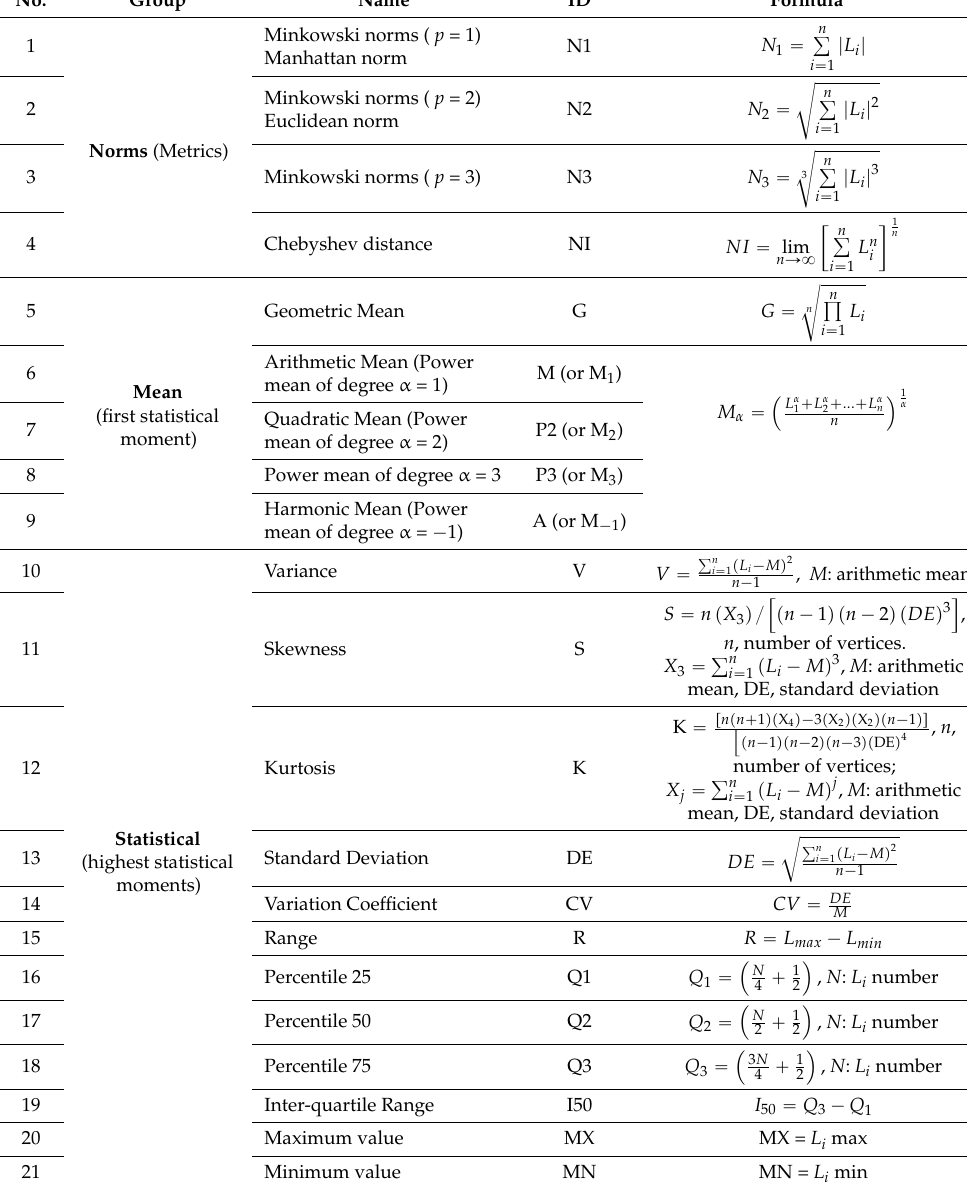
Table 1. Invariants functions employed to derive molecular descriptors (total and local) from local vertex invariants